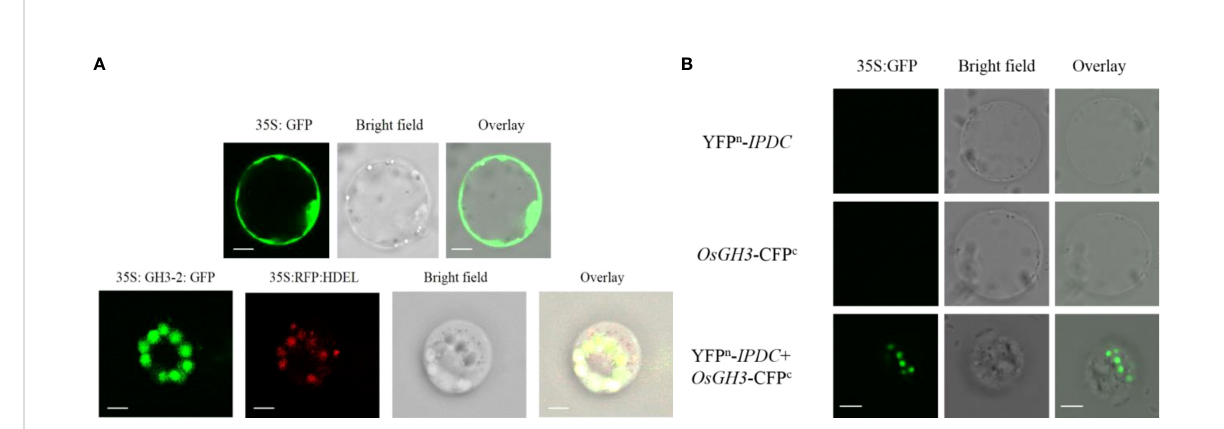
FIGURE 3 (A) Subcellular localization of 35S: GH3-2 :GFP using rice protoplast 35S; green fl uorescent protein (GFP) was used as a positive control. Left to right: green fl uorescent protein of OsGH3-sGFP is shown in green color; red fl uorescence shows RFP:HDEL (ER marker), bright fi eld, and overlay microscope images. GH3s are most consistently localized to the ER membrane. Scale bars = 10 µm. (B) Protein interaction of GH3 and ipdc using rice protoplasts. Scale bars = 10